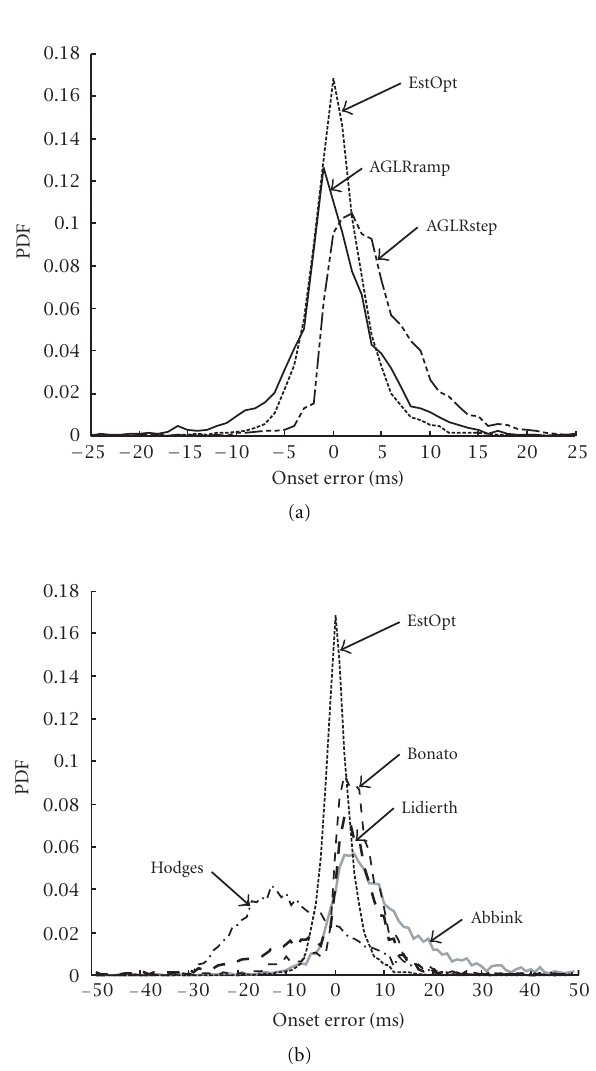
Figure 3: Probability density functions (PDFs) of onset estimation errors for the Mixed Trials data set (SNR 6–12dB, ramp duration 5–30ms). Note the different abscissa scaling in (a) and (b).